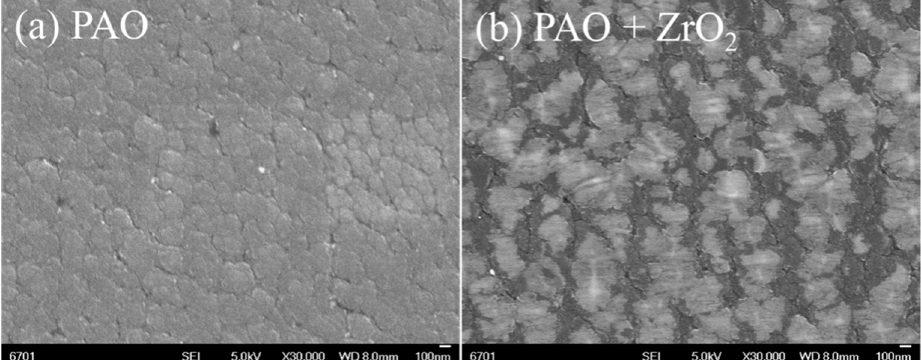
Figure 6. The FESEM images of worn a-C surfaces under the lubrication of: ( a ) pristine PAO oil; and ( b ) ZrO 2 -NPs dispersion.